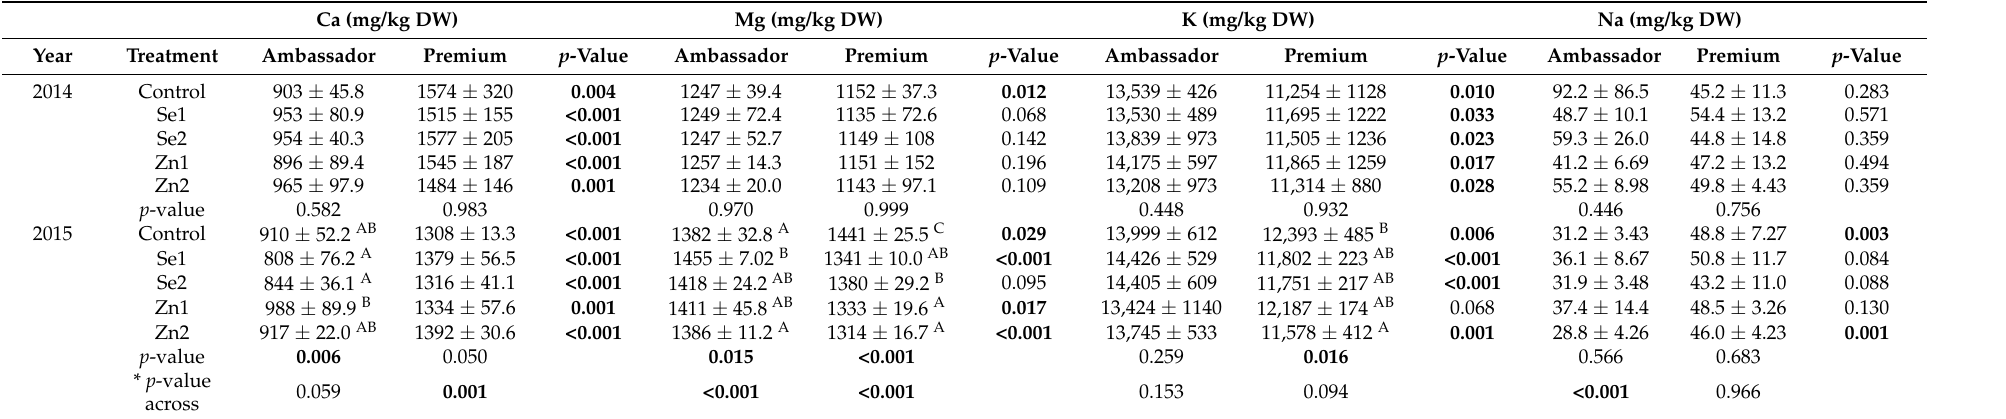
Table 2. Effect of foliar-applied Se and Zn, variety and year on seed Ca, Mg, K and Na